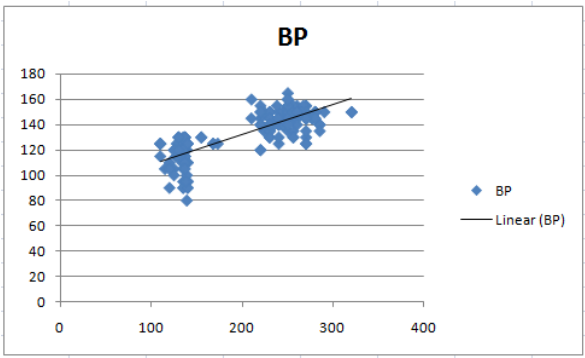
Figure 9. Correlation between blood pressure and diabetic patients